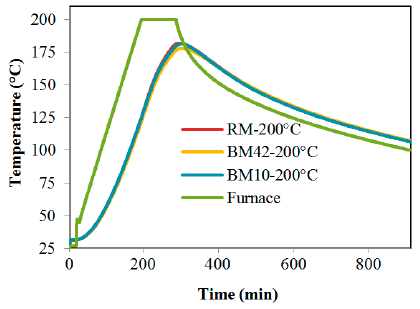
Figure 8. Heating regime of mixtures RM, BM 10 and BM 42 for 200 °C.